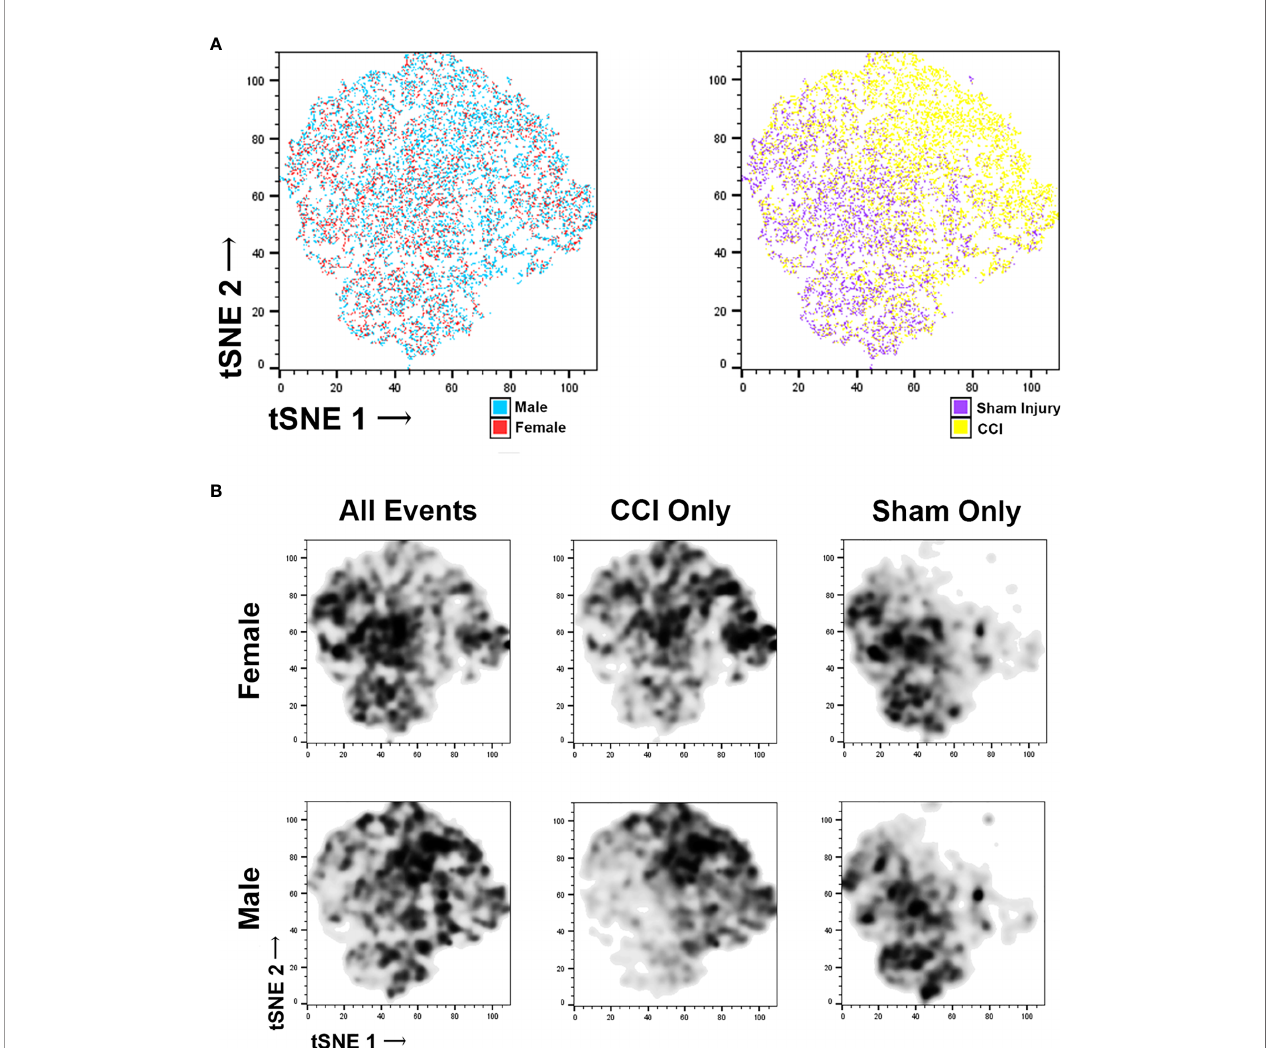
FIGURE 3 | t ‐ Distributed stochastic neighbor embedding (t-SNE) of microglia fl ow cytometry data. Each individual data point in the tSNE plot represents individual microglia counted through the fl ow cytometer. The colors applied to the plots (A) allow us to distinguish the microglia based upon their sex (male or female) or their injury (sham or CCI). The colorless plots (B) represent density plots of the same microglia data portrayed in the color tSNE plots. The density plots depict speci fi c microglia populations by highlighting the microglia representative of speci fi c experiment groups. When viewing all microglia (CCI and sham injury) separated on the basis of sex, there are speci fi c populations that are clear to distinguish, as expected. When viewing each sex group of only CCI injury, some minor differences are noted, but the microglial populations occupy similar areas, indicating that there are likely more similarities. The density plots of sham groups similarities between the male and female groups as